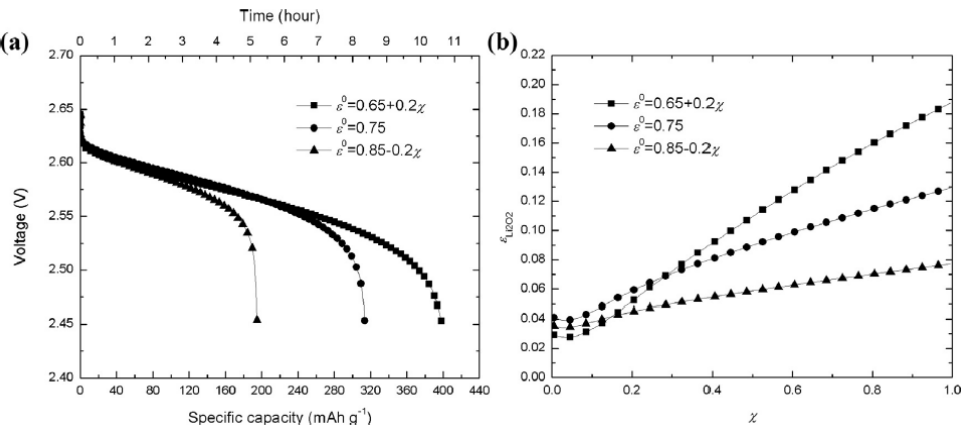
Figure 35. ( a ) Performance curves of Li-air cells and ( b ) distribution of Li 2 O 2 volume fractions of active Li–oxygen cells with gradient electrode porosities. Republished from Li et al. [46] with permission of The Electrochemical Society conveyed through Copyright Clearance Center, Inc.